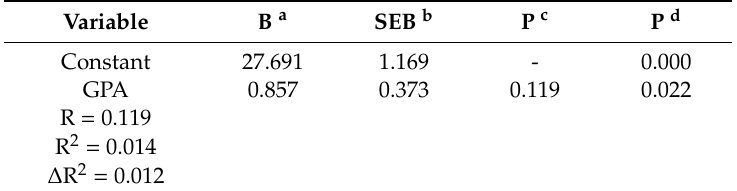
Table 5. Results of standard regression analysis predicting PL using GPA ( n =